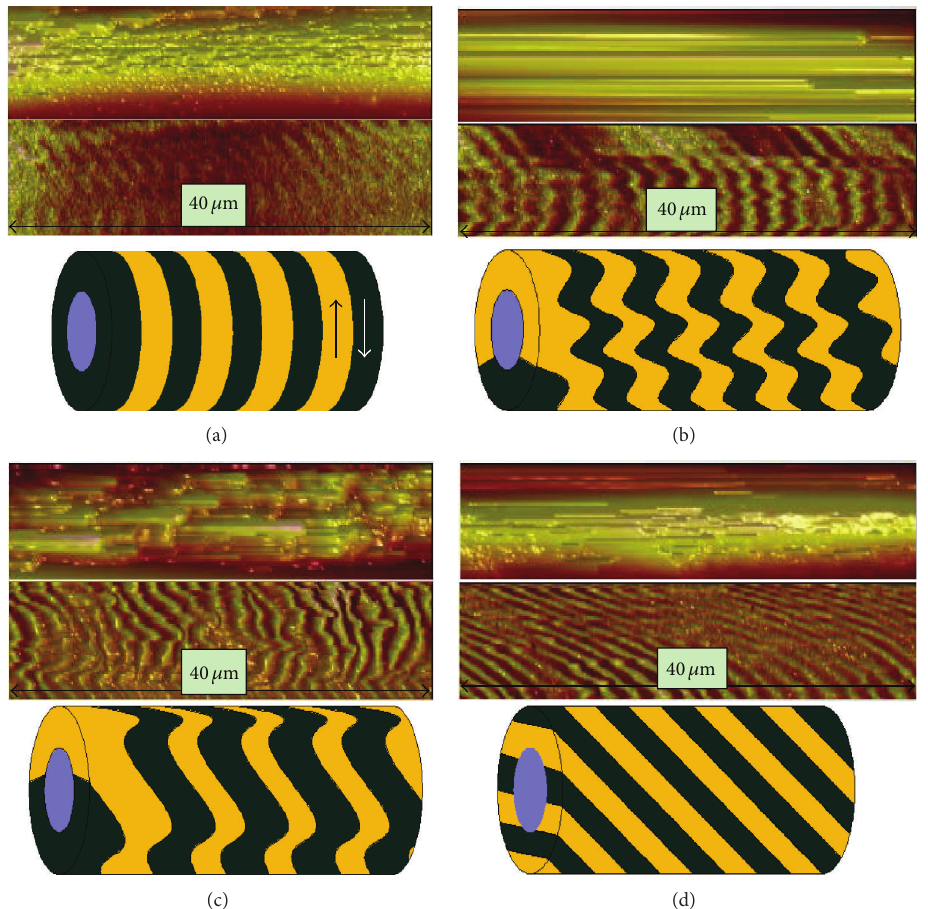
Figure 3: Surface domain structures transition and corresponding schematic diagrams of Co 68.15 Fe 4.35 Si 12.25 B 13.25 Nb 1 Cu 1 amorphous wires: (a) as-prepared and under different values of the applied torsion in the clockwise sense: (b) 𝜉 = 20.4 (2 𝜋 rad/m), (c) 𝜉 = 61.2 (2 𝜋 rad/m), and (d) 𝜉 = 81.6 (2 𝜋 rad/m).